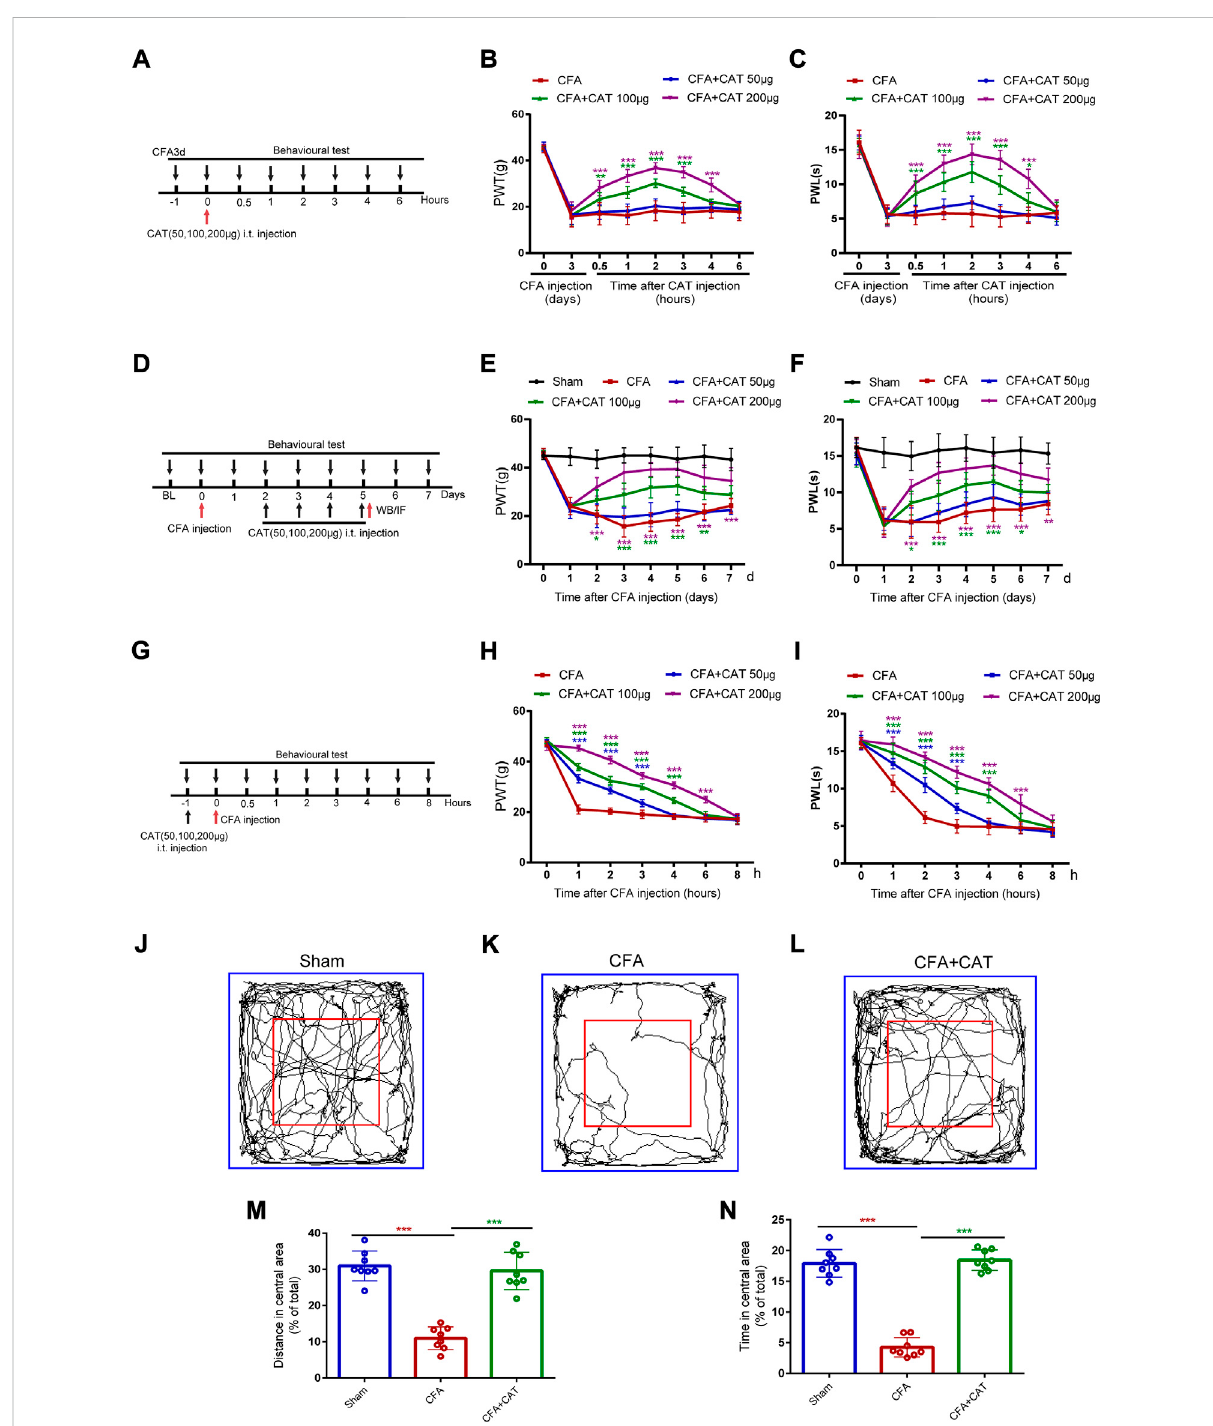
FIGURE 1 Catalpol could alleviate CFA-induced in fl ammatory pain in rats. (A). Timeline for single treatment of catalpol. (B,C). Effect of signal treatment of catalpol(50,100,200 μ g,it.)onPWTinresponsetoVonFrey fi lamentstimulationandPWLinresponsetothermalstimulation.PWT:Pawwithdrawal threshold; PWL: Paw withdrawal latency. (D). Timeline for repeated injections of catalpol. (E,F). Effect of repeated injections of catalpol (50, 100, 200 μ g, i. t.) on PWT and PWL. (G). Timeline for pre-administered treatment of catalpol. (H,I). Effect of pre-administered treatment of catalpol (50,100,200 μ g,i.t.)onPWTandPWL.(* p < 0.05,** p < 0.01,and*** p < 0.001vs.theCFAgroup;n=6,two-wayrepeatedmeasuresANOVA). (J – L). RepresentativetracesoflocomotoractivityintheOpen fi eld. (M). DistancetraveledinthecentralareaintheOpen fi eld. (N). Timespentinthecentral area in the Open fi eld. ( ppp p < 0.001 vs. CFA group; n = 8, one-way